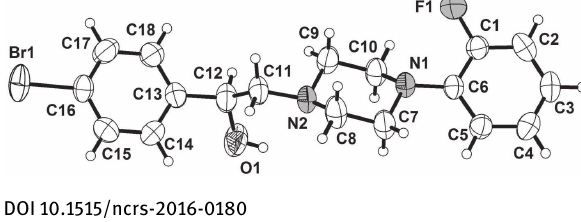
Table 1: Data collection and handling.